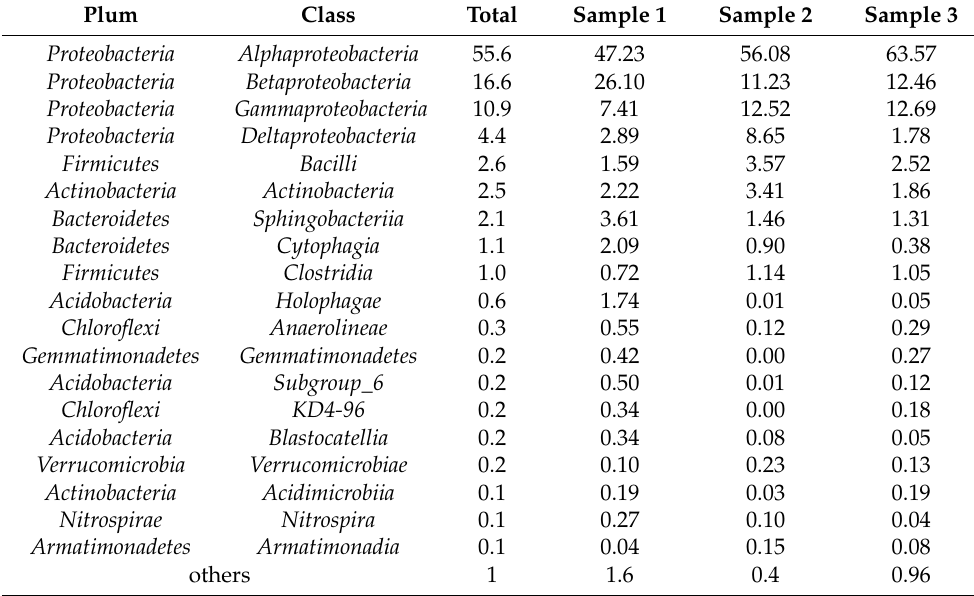
Table 5. Percentages of the major classes in each SSF